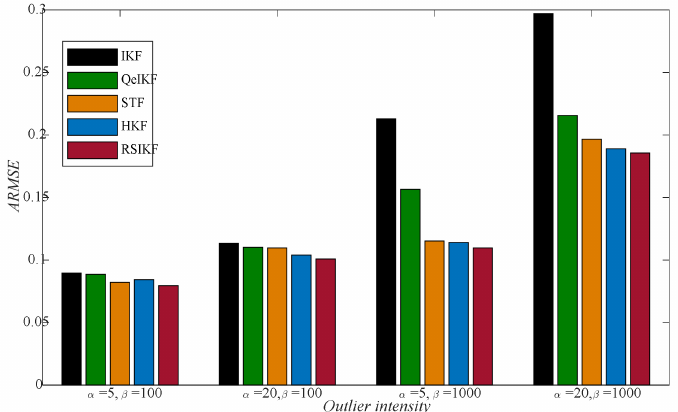
Figure 7. The ARMSE result of RSIKF with different N for all cases of α and β .